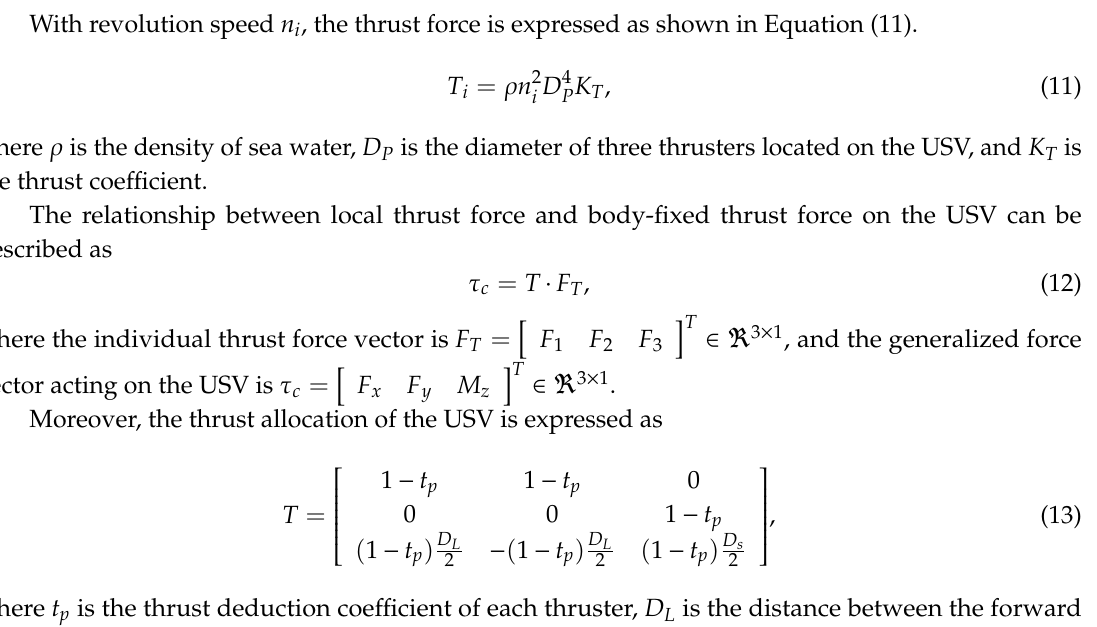
Figure 9. Thruster arrangement of the USV.